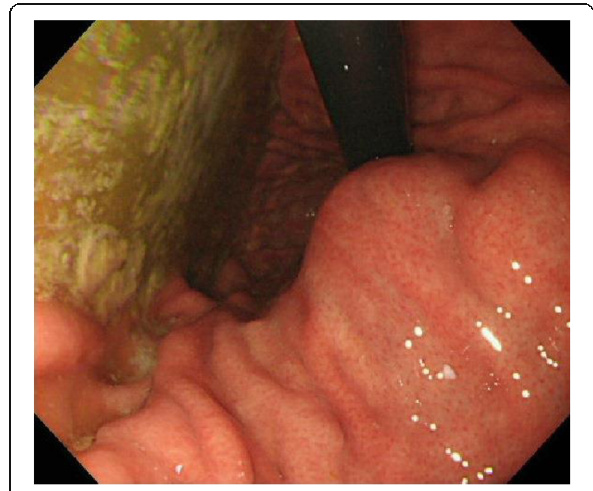
Fig. 1 An inverted image inside the stomach upon upper